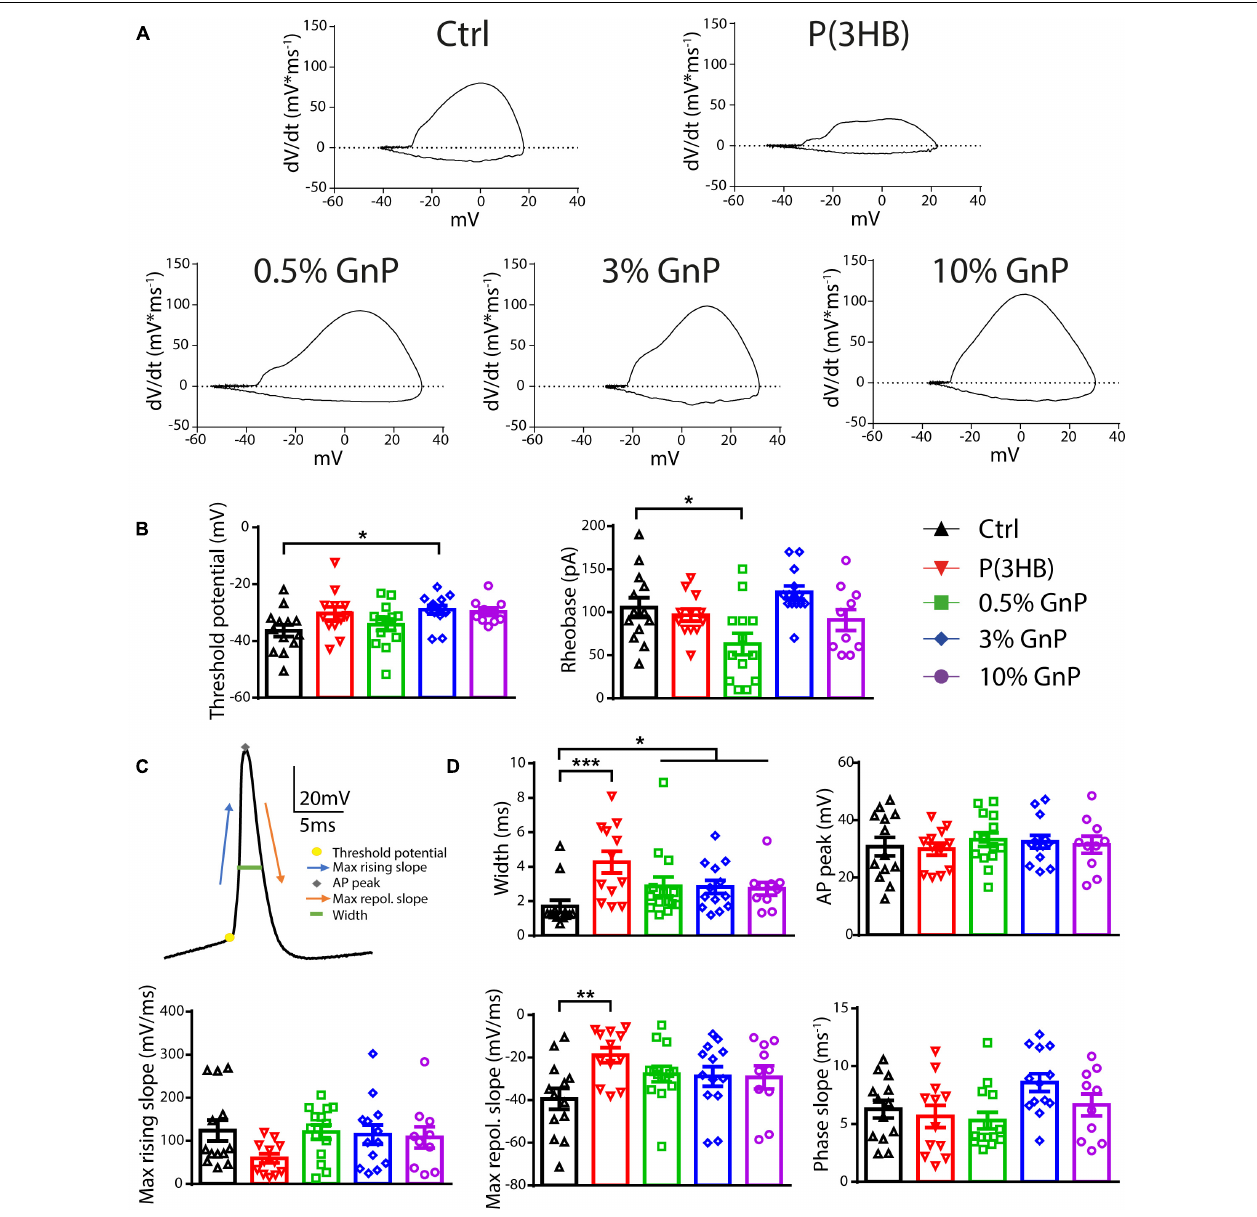
FIGURE 4 | Passive and active properties of primary cortical neurons plated upon P(3HB)/GnP composites. Neurons were plated in various GnP concentrations (0.5, 3.0, and 10.0% GnP) and two control conditions [glass and P(3HB)] for 14 days. (A) Representative phase-plane plots of the first action potential in the train are shown. (B) Threshold potential (left) and rheobase (right) are shown. (C) Representative shape of the first AP showing its main parameters. (D) Width (upper panel, left), AP peak (upper panel, right), maximum rising slope (lower panel, left), maximum repolarizing slope (lower panel, center), and phase slope (lower panel, right) are shown. Cortical neurons plated onto GnP supports displayed a small but significant enhancement in the AP width; in addition, cortical neurons plated on P(3HB) supports showed an increased width and maximum repolarizing slope. All data are expressed as means ± SEM; one-way ANOVA/Kruskal-Wallis test and Dunn’s post hoc test, n = 13, 12, 14, 13, and 10 for Ctrl, P(3HB), 0.5, 3.0, and 10.0% GnP, respectively, from two independent neuronal preparations. * p < 0.05; ** p < 0.01; *** p <